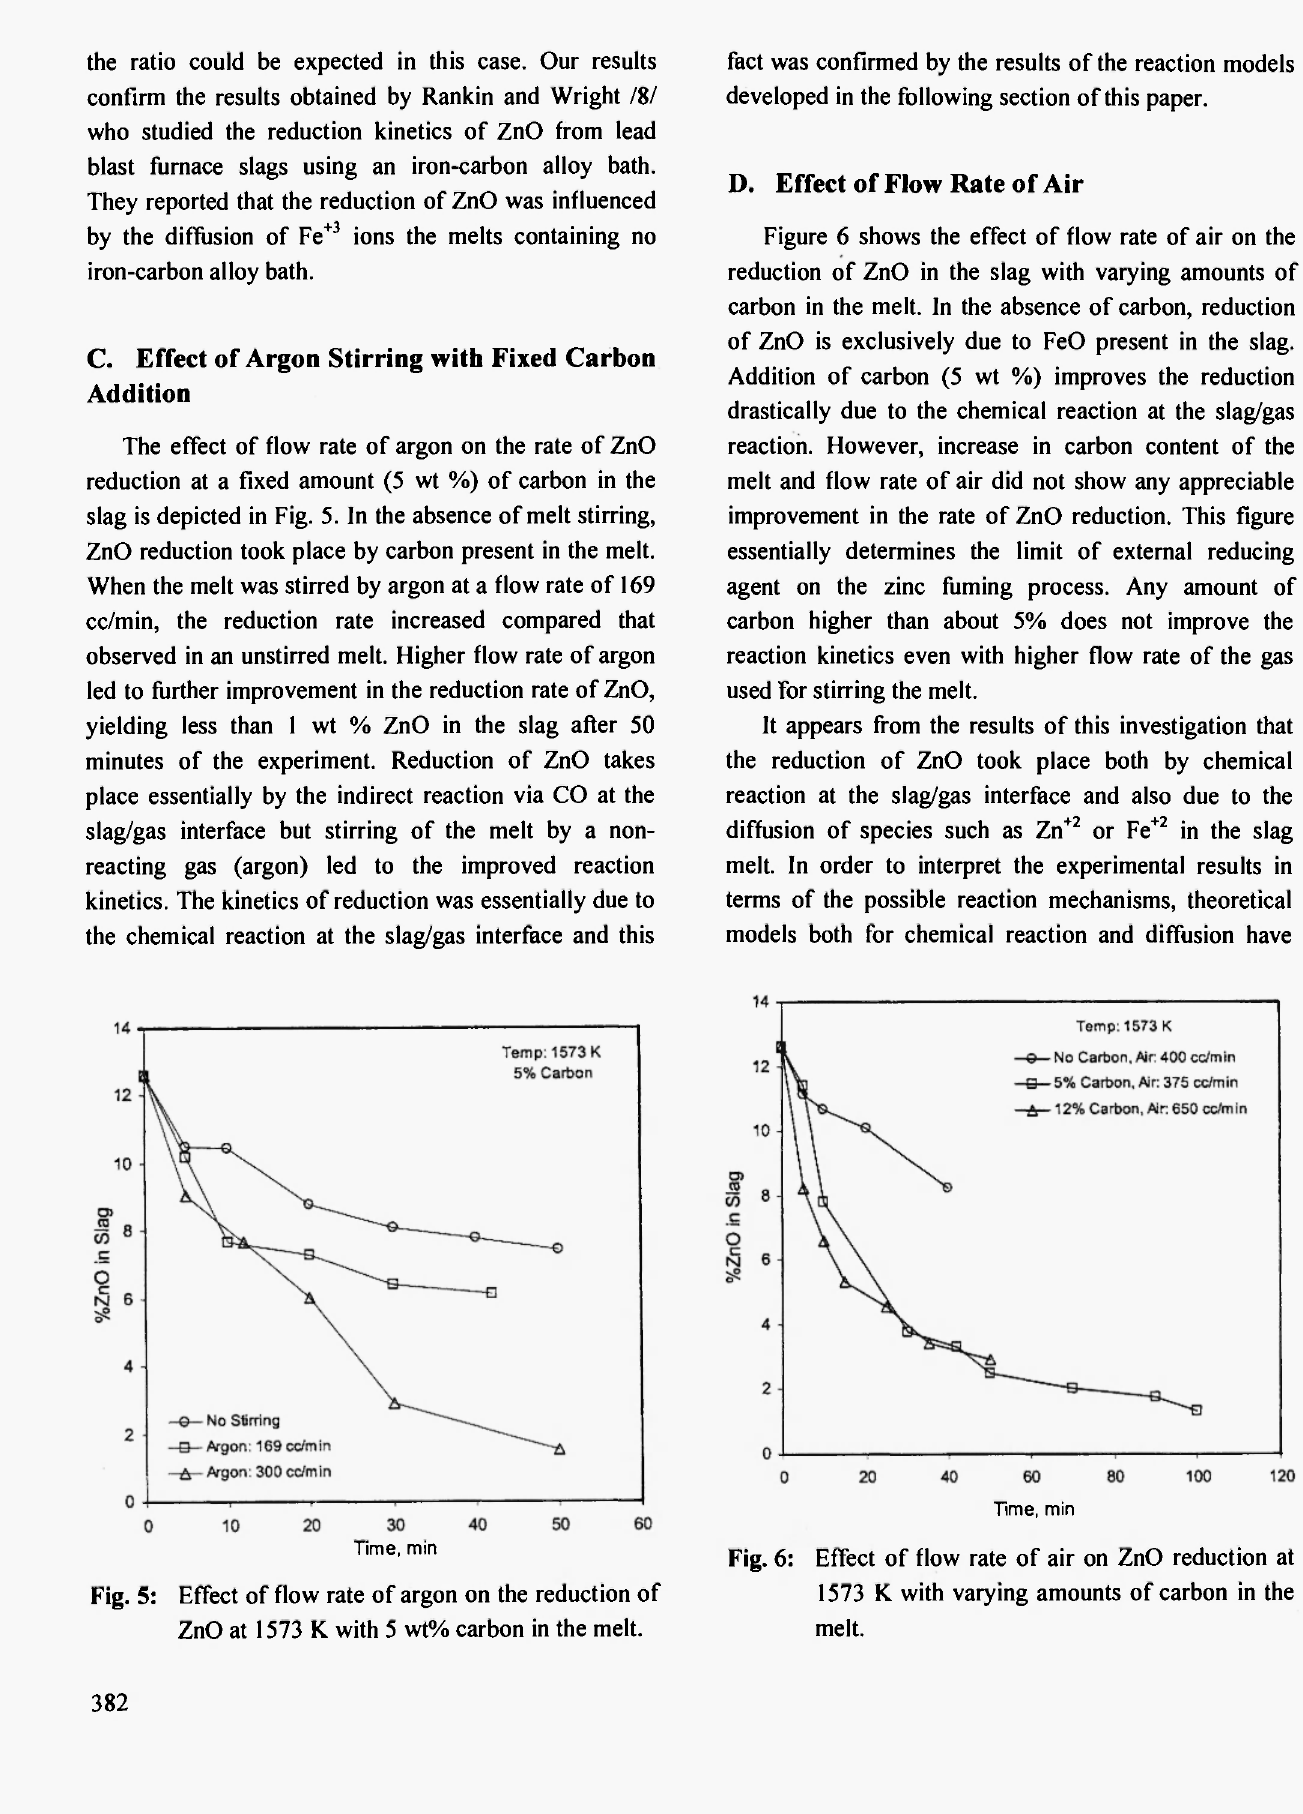
Fig. 5: Effect of flow rate of argon on the reduction of ZnO at 1573 Κ with 5 wt% carbon in the melt.